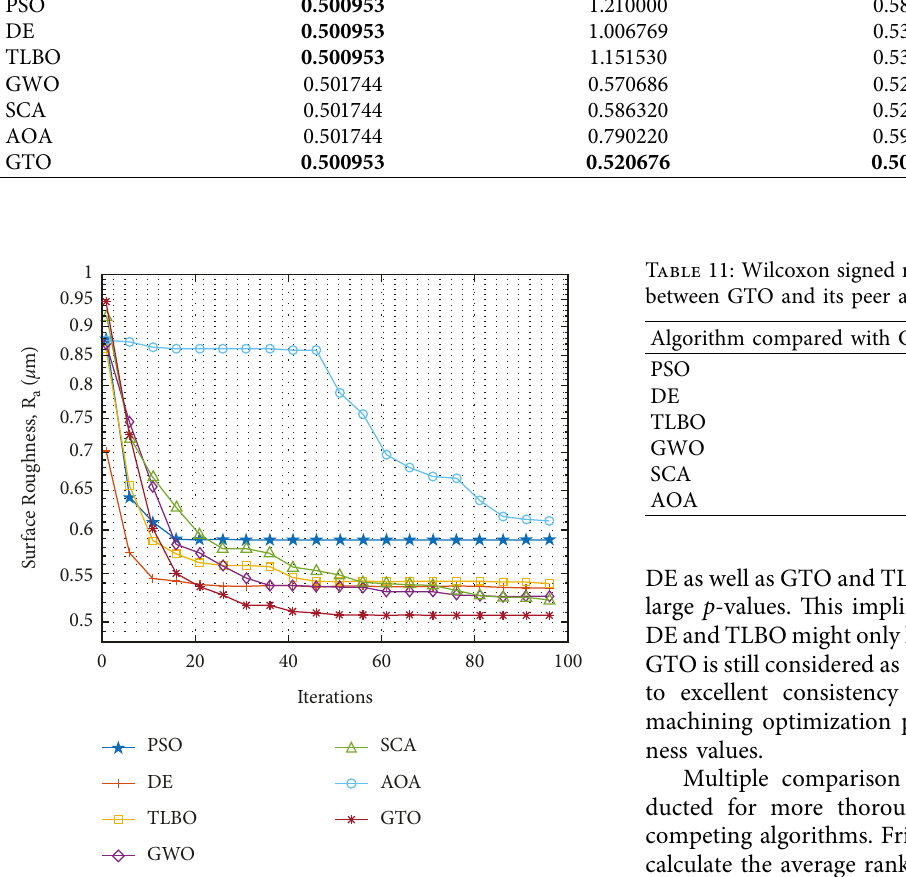
Figure 3: Convergence curves produced by all compared meta- heuristic search algorithms.